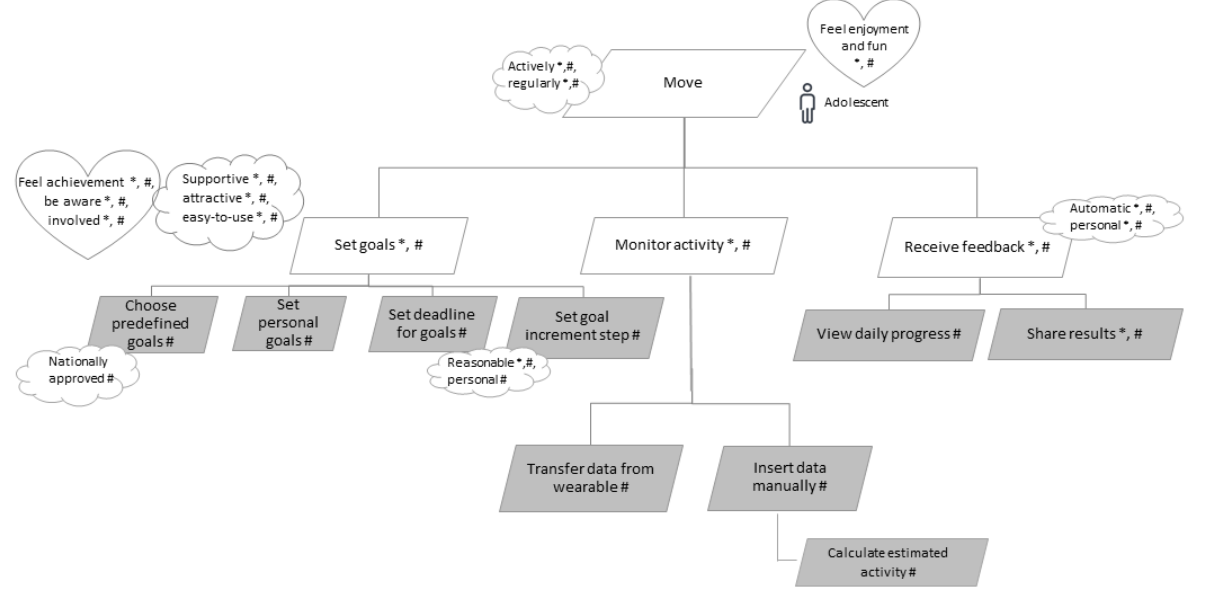
Figure 3. Sublevel models for the functional goals “set goals,” “monitor activity,” and “receive feedback.” The “*” in the model represents findings from the literature; the “#” represents suggestions by experts; gray rectangles represent functionalities at the level of user